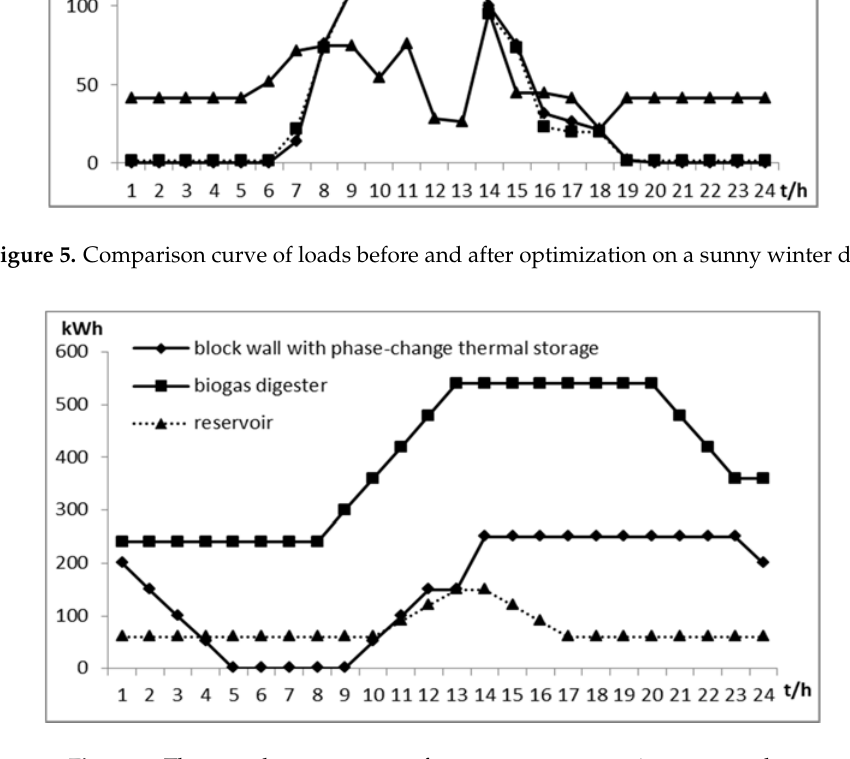
Table 2. Timetable of loads and energy storages working time before and after optimization on a sunny winter day.